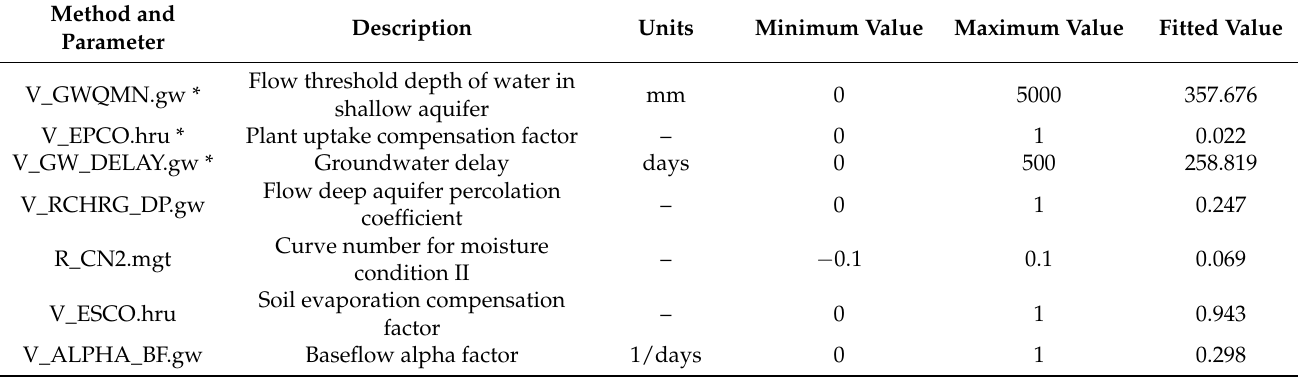
Table 3. The parameters used in the calibration procedure of streamflow between 1982 and 1987, in the Uberaba River basin. In the legend of methods, R is relative and V is the replacement value. The asterisk (*) represent the parameters statistically significant ( p ≤